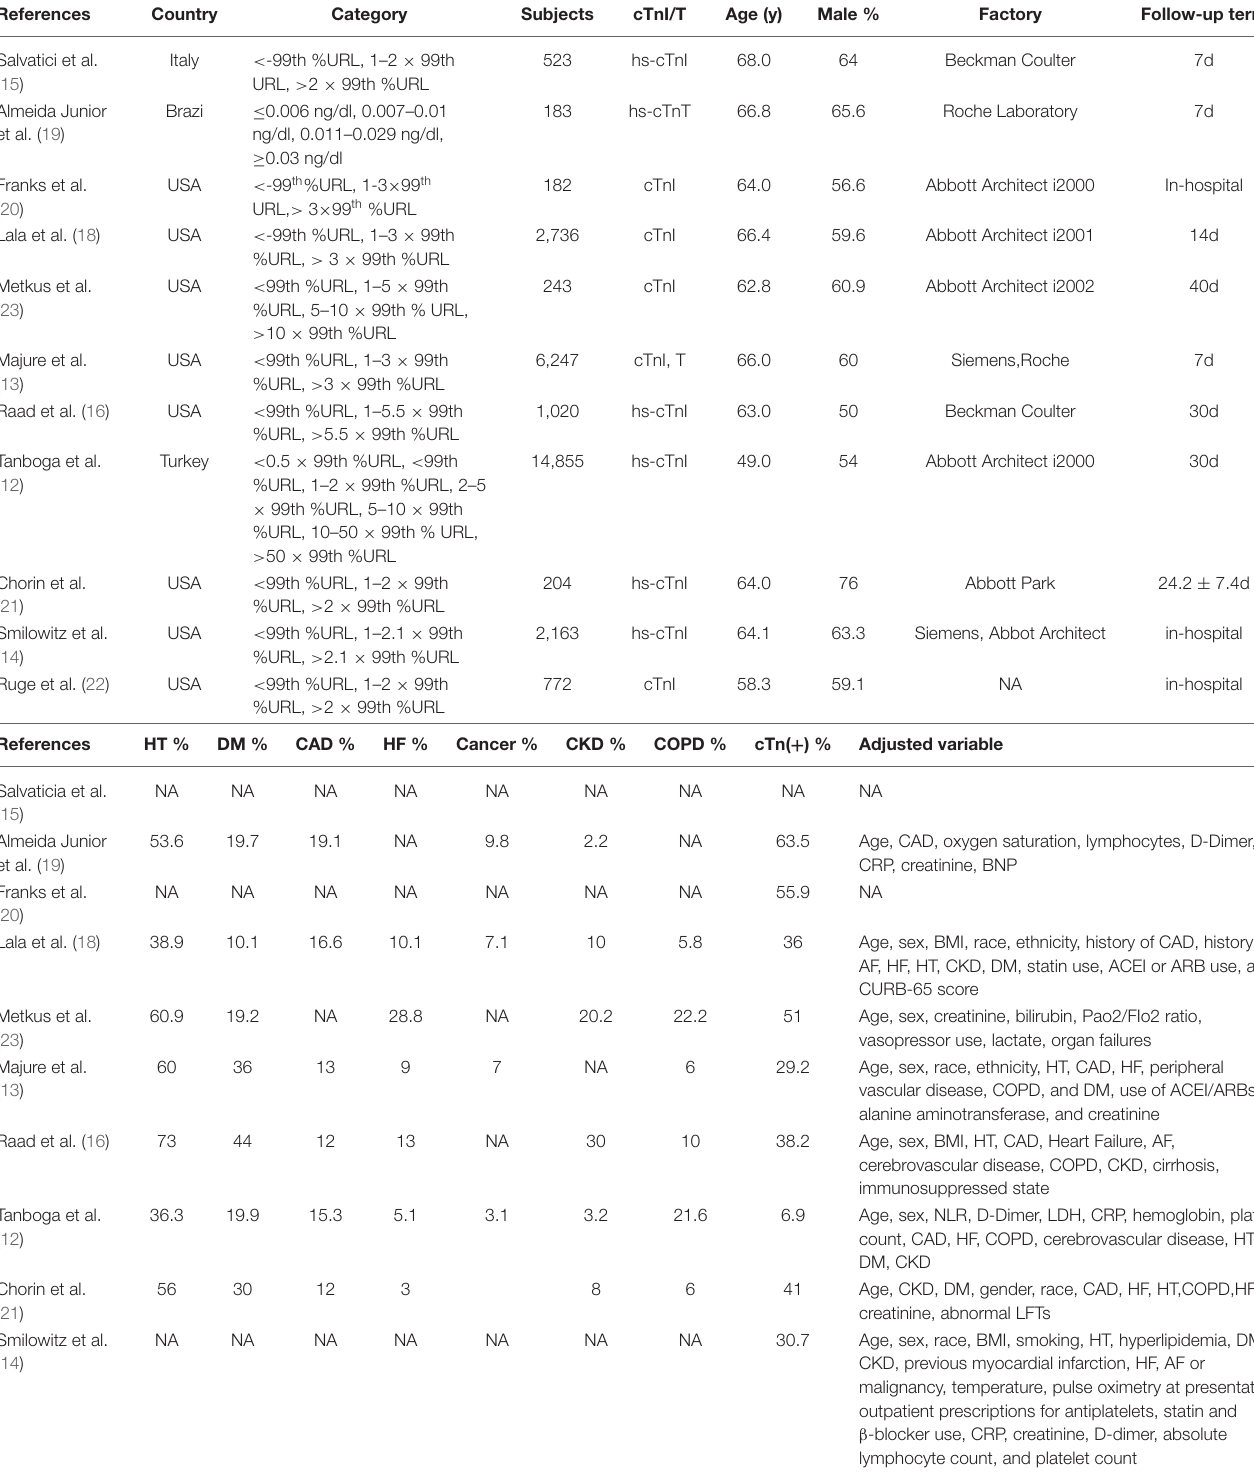
TABLE 1 | Characteristics of included